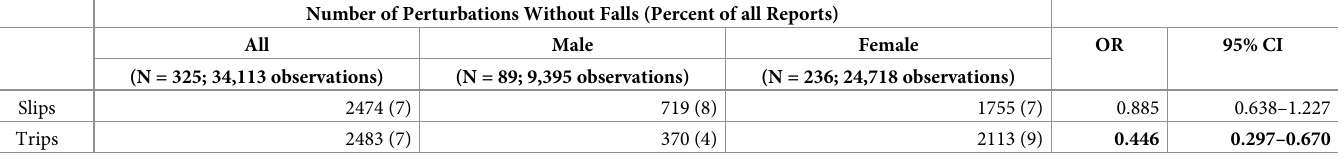
Table 3. Frequency of reported slips and trips–that did not result in a fall–for males versus females. Number of Perturbations Without Falls (Percent of all Reports) All Male Female